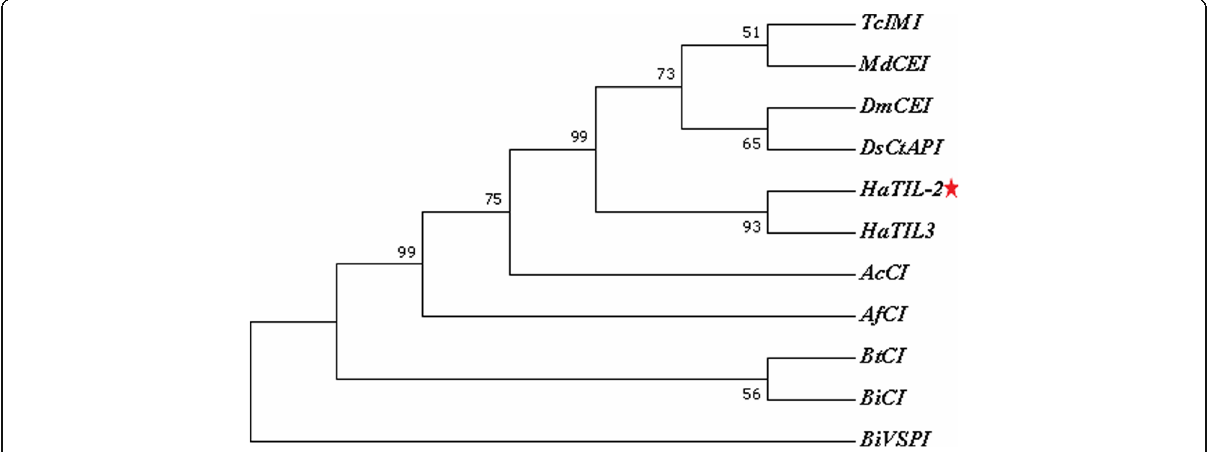
Fig. 2 Phylogenetic relationship of HaTIL2 with cysteine-rich proteases of other insects. The sources of the sequences were Helicoverpa armigera TIL2 (this study, GenBank accession no. MN836536), H. armigera TIL3 (AHX25885.1), Tribolium castaneum IMI (XP_008201444.1), Musca domestica CEI (XP_005177283.1), Drosophila miranda CEI ( XP_017134624.1 ), Drosophila suzukii CtAPI ( XP_016937015.1 ) A. florea CI (XP_003696076), Bombus ignitus VSPI (AGY95442.1), B. terrestris CI (AFX62368.1), B. impatiens CI (XP_003484766.1), and A. cerana AcCI